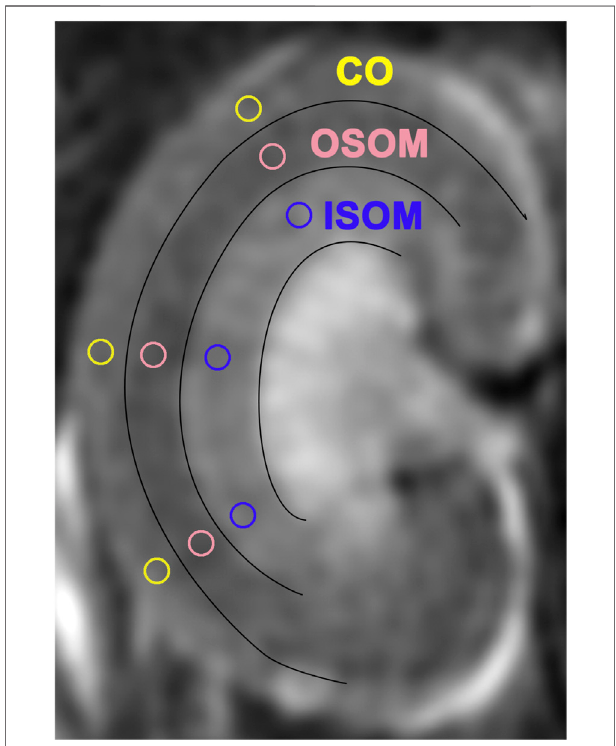
FIGURE 2 | Regions of interest (ROIs) in three sectors of T2-weighted images. ISOM: inner stripe of the outer medulla; CO: cortex; OSOM: outer stripe of the outer